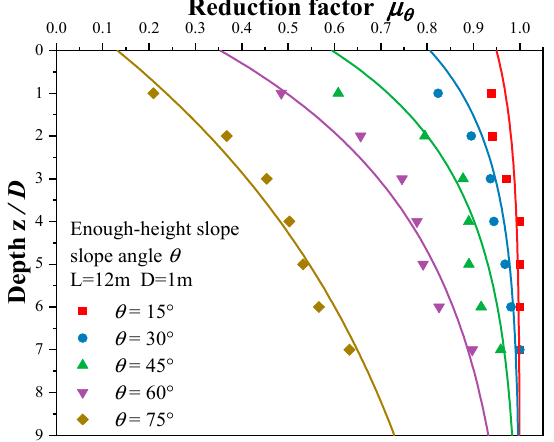
and 60 ◦ slope angles. 45°, and 60° slope angles.